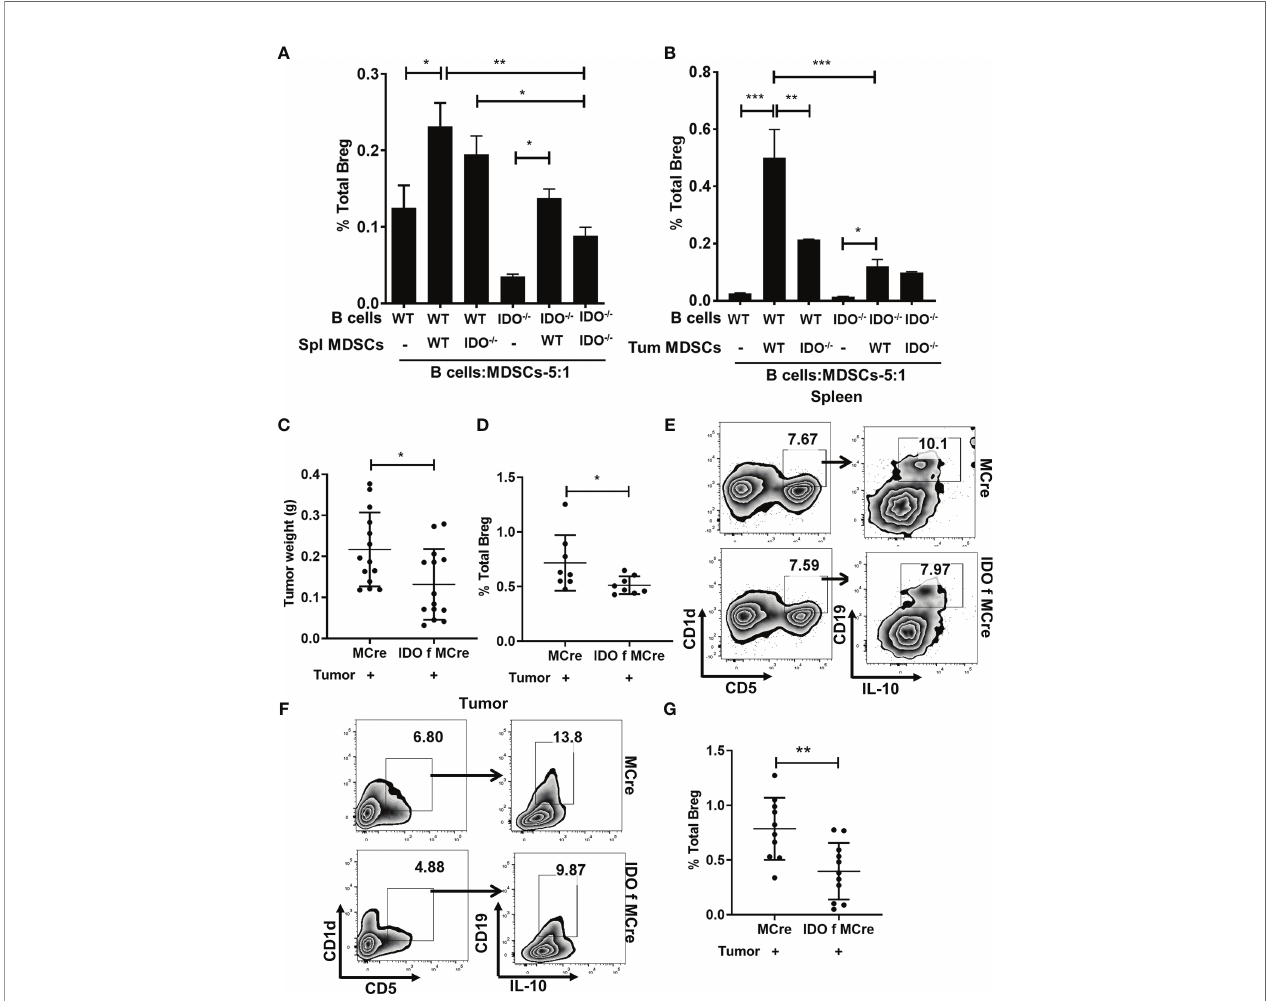
FIGURE 2 | MDSCs expressing IDO promotes Breg differentiation. (A) CD19 + B cells were puri fi ed from splenocytes of WT and IDO -/- naïve mice and co-cultured in 5:1 ratio with MDSCs sorted from the spleen of tumor-bearing WT and IDO -/- and incubated for 72 hrs. Bregs were identi fi ed in the co-culture as CD19 + CD5 + CD1d hi IL-10 + by fl ow cytometry. Data shown here are representative of three independent experiments with three replicates for each group and represent the mean ± STDEV values. (B) CD19 + B cells were puri fi ed from splenocytes of WT and IDO -/- naïve mice and co-cultured in 5:1 ratio with MDSCs sorted from tumor of WT and IDO -/- and incubated for 72 hrs. Bregs were identi fi ed in the co-culture as CD19 + CD5 + CD1d hi IL-10 + by fl ow cytometry. Data shown here are representative of three independent experiments with three replicates for each group and represent the mean ± STDEV values. (C) Conditional deletion of IDO in myeloid cells (IDO f MCre) reduced tumor burden (g) compared to control MCre mice on Days 9 of tumor implant (n = 14 mice per group). (D) Representative fi gure of FACS analyses of splenic tissue con fi rmed reduction of Breg (CD19 + CD5 + CD1d hi IL-10 + ) in tumor-bearing IDO f Mcre on day 9 post tumor implant. (E) Diminished Breg frequency in IDO f Mcre mice with lung cancer compared to MCre control on Days 9 post tumor implant (n = 8 mice per group). Total percentage of Bregs (CD19 + CD5 + CD1d hi IL-10 + ) were determined by fl ow cytometry analysis. (F) Representative FACS plot of tumor tissue con fi rming reduction of Breg in IDO f MCre on day 9 of tumor implant. (G) Reduced Breg frequency in lung tumor of IDO f MCre mice compared to MCre control on day 9 of tumor implant (n = 10-11 mice per group). *p < 0.05, **p < 0.001, ***p <